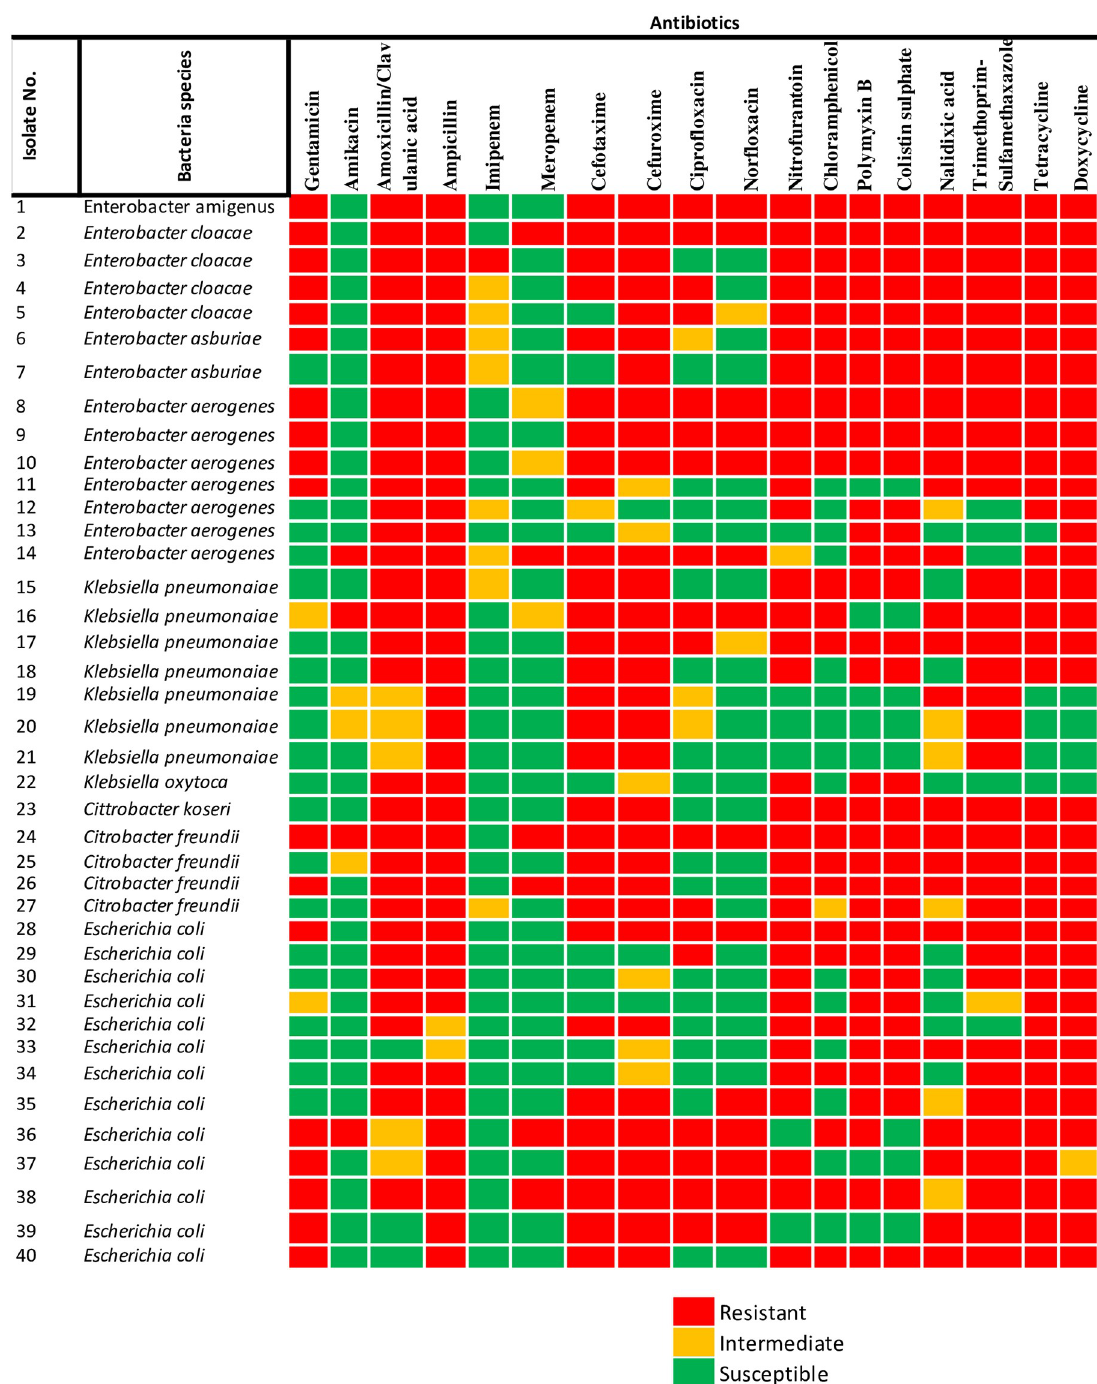
Fig 5. Members of Enterobacteriaceae isolated from rivers, indicating the phenotypic antibiotic resistance profiles. The colour codes indicate resistant, intermediate, and susceptible phenotypes to specific eighteen antibiotics belonging to eleven classes.